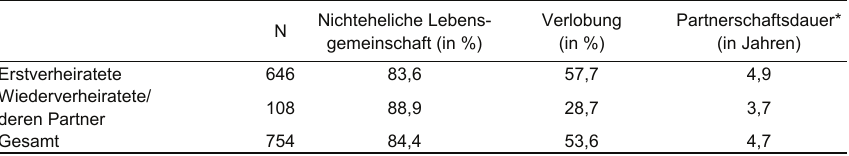
Tab. 3: Der Partnerschaftsverlauf vor der Ehe: Kohabitation, Verlobung